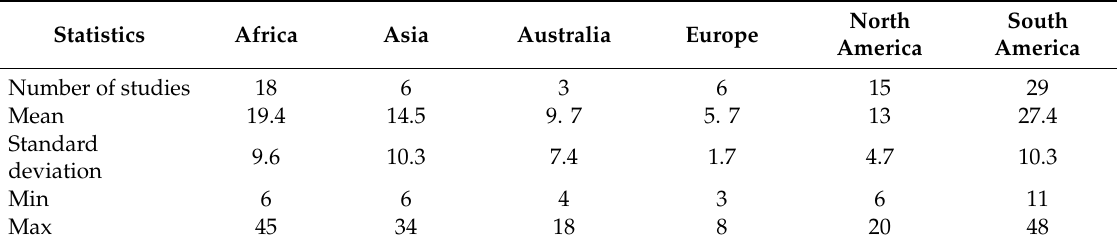
Table 1. Synopsis of the number of species (and dispersion measures) of sympatric snakes among continents, on the basis of the selected studies.